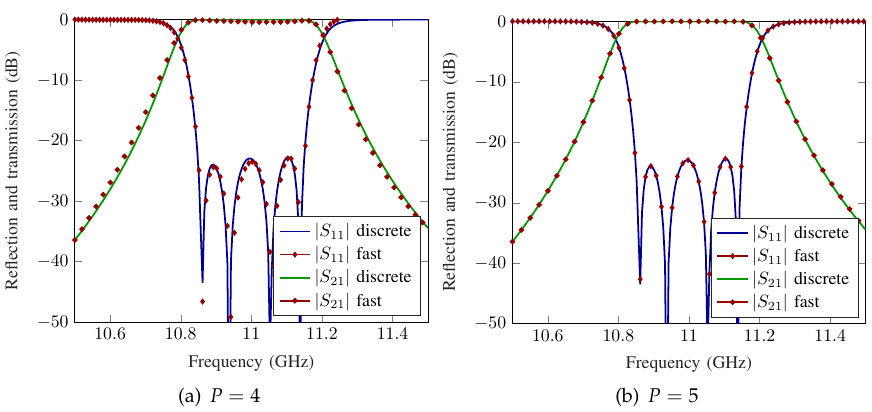
Figure 10. Comparison between accurate and approximate scattering parameters of different blocks (posts) of the coupled cavities filter with dielectric posts, and different combinations of input and output ports and modes. Big dots show the points used for spline approximation (five points in this case).